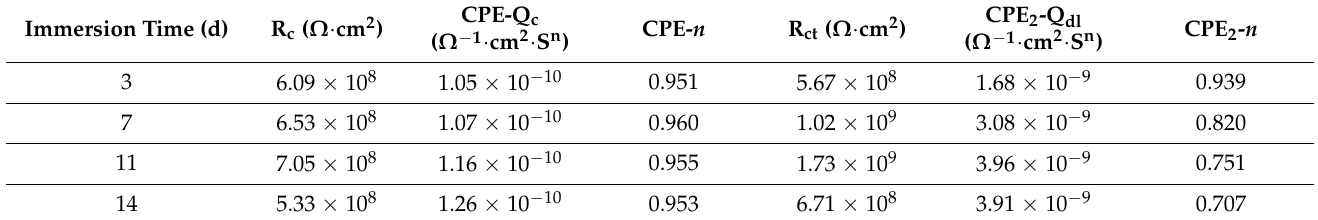
Figure 8. The Bode plot ( a,d ), phase plot ( b,e ), and Nyquist plot ( c,f ) of the #85 and #18 electrodes after the immersion in the T. funiculosus -contained medium. Table 2. EIS fitting results of the #85 electrode immersion in the T. funiculosus -contained medium for different